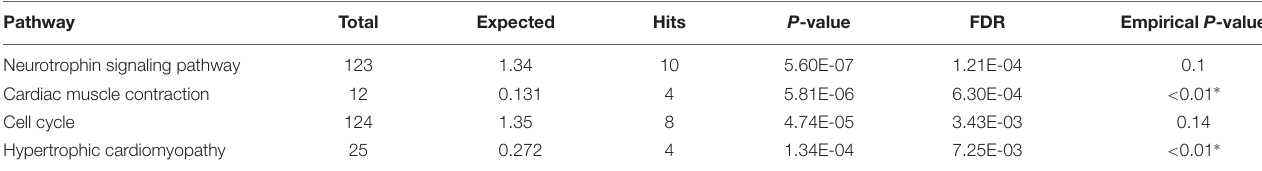
TABLE 2 | KEGG pathways enriched among the PPI network formed by JIA loci target gene and their interactors (FDR < 0.05). Pathway Total Expected Hits P -value FDR Empirical P